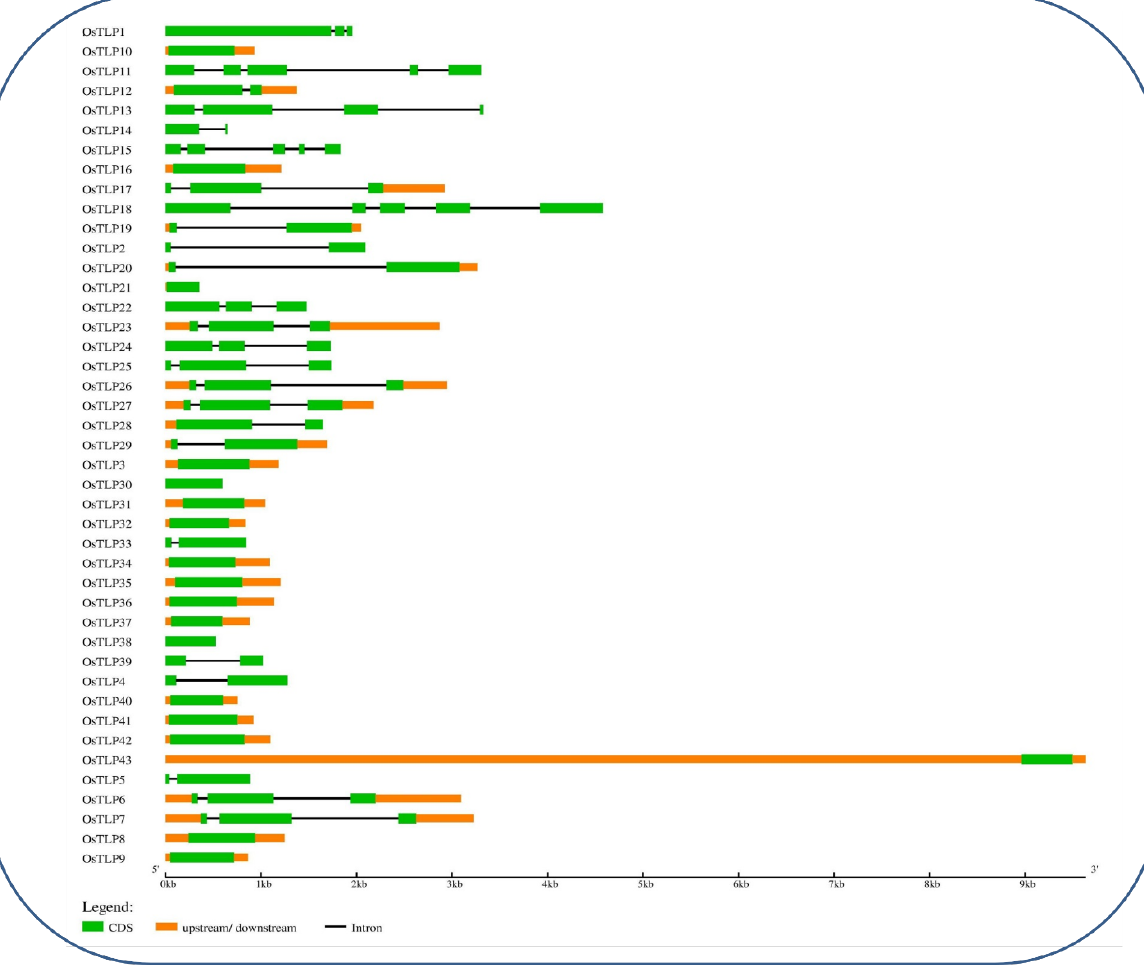
Figure 2. Schematic representation of the gene structure of TLP genes in Oryza sativa . To further study the phylogenetic relationship of OsTLP in Oryza sativa , conserved motifs were identified using the University of Nevada, Reno, Nevada, USA; University of Washington, Seattle, Washington, USA; University of Queensland, Brisbane, Australia and University of California, San Diego, California, USA) developed MEME server (Ver- sion 5.4.1) https://meme-suite.org/meme/ (accessed on 15 march 2022) [36] (Figure 3). The motifs were variously allocated on the OsTLP genes. Among these, OsTLP25 , OsTLP28 , OsTLP7 , OsTLP6 , OsTLP27 , OsTLP17 , OsTLP23 , OsTLP19 , OsTLP26 , OsTLP20 , OsTLP22 , OsTLP24 , OsTLP33 exhibit 9 motifs each, followed by OsTLP10 , OsTLP8 , OsTLP1 , OsTLP29 , OsTLP43 , and OsTLP38 with 8 of motifs. Further, OsTLP36 , OsTLP32 , OsTLP42 , OsTLP40 , and OsTLP39 were observed with 6 motifs. Several members of the OsTLP gene family were found with fewer motifs, such as OsTLP18 , OsTLP13 , and OsTLP4 with 4 mo- tifs, OsTLP4 with 2 motifs, and OsTLP5 with a single motif.